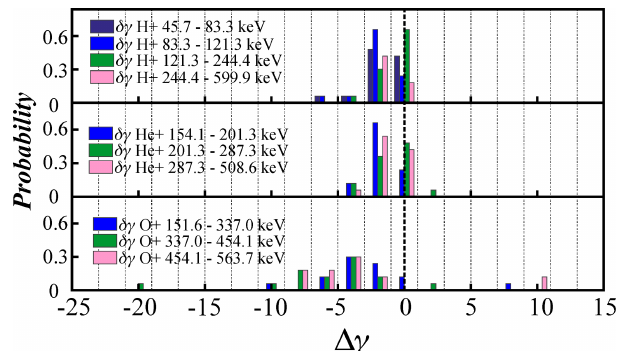
Figure 6. Distribution of probability to observe the given values of γ variations (see explanation in the text) for H + , He + and O + ion components. For each ion component the energy ranges used for γ calculation are indicated by colors according to a legend shown in the corresponding panel.